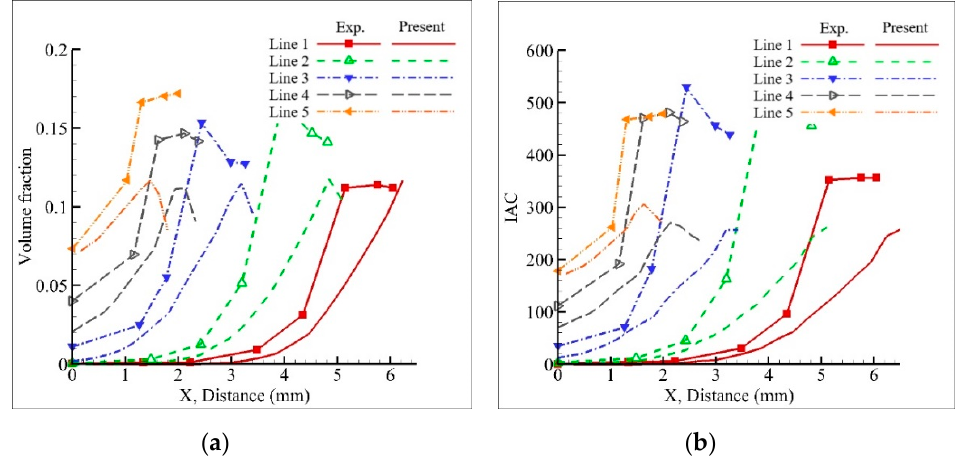
Figure 11. Case 5 numerical results of Lines 1–5 compared with experiment results: ( a ) volume fraction and ( b ) interfacial area concentration.